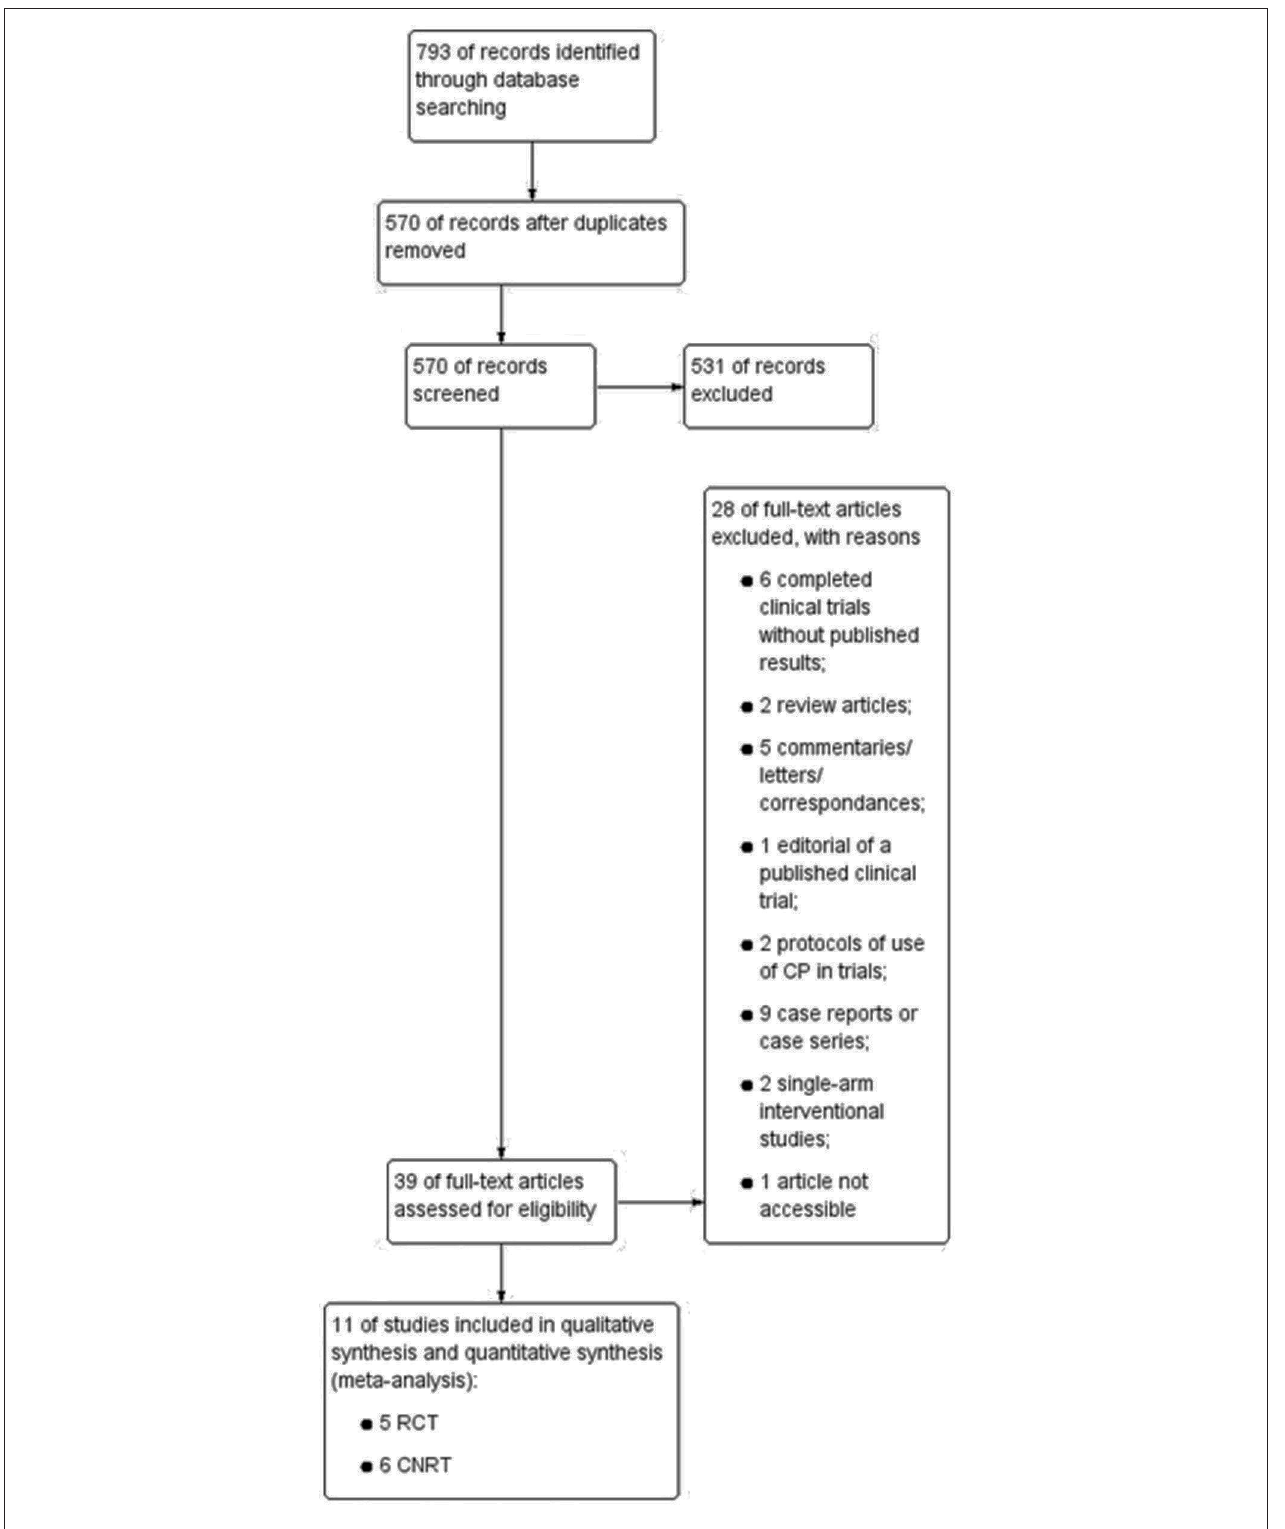
FIGURE 1 | PRISMA Flow diagram illustrating the study selection process. Schematic illustration indicating the various steps from the Database search until the inclusion of the selected trials for this meta-analysis. The number of trials excluded, and the reason for exclusion are also described in this scheme. RCT, Randomized Clinical trials; CNRT, Controlled Non-Randomized